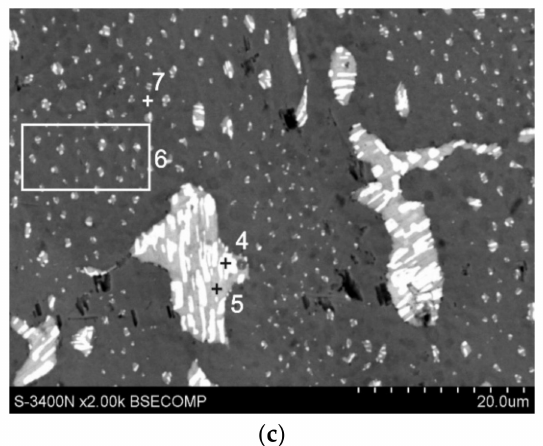
Figure 4. SEM images of the top surface of Zn-AlNiBiSn coating: ( a ) outlook of the coating surface, ( b , c ) BiSn precipitation in a zinc matrix. Table 2. The results of the microanalysis of the composition in marked points visible on Figure 4. Content of Elements Zn-K Sn-L Bi-M Points of Microanalysis wt.% at.% wt.% at.% wt.% at.% 1 95.8 98.1